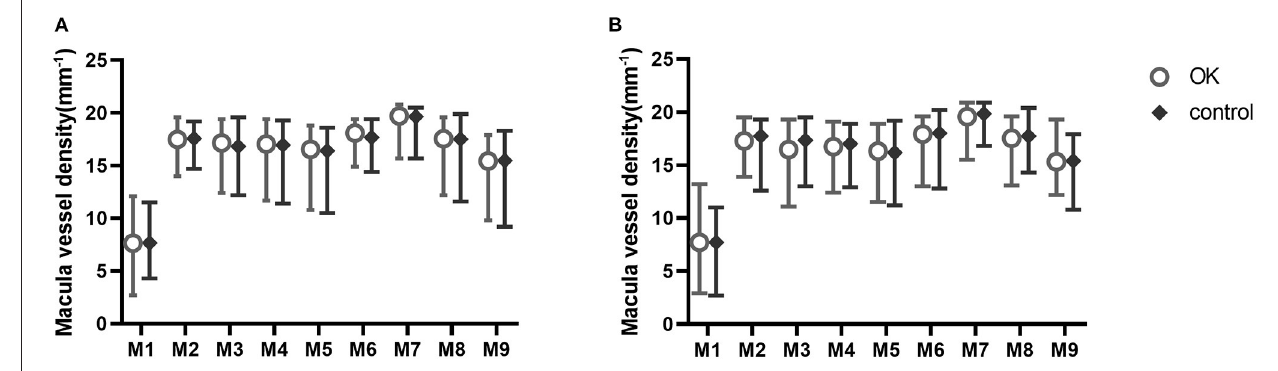
FIGURE 4 | Nine zones of macular vessel density at baseline (A) and at 6 months (B) .